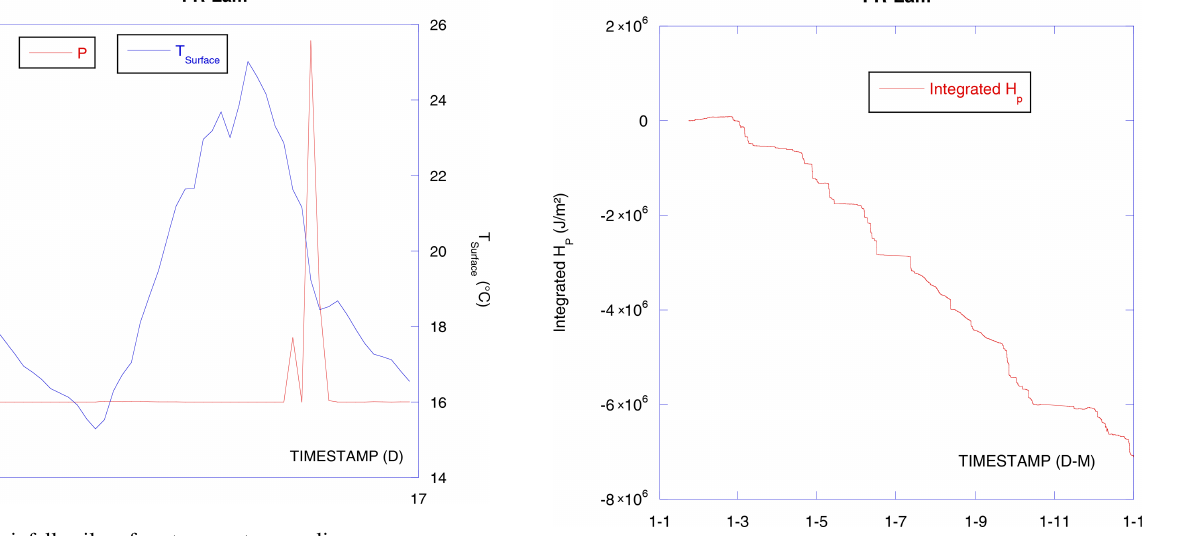
Figure 7. Integrated rainfall cooling H P